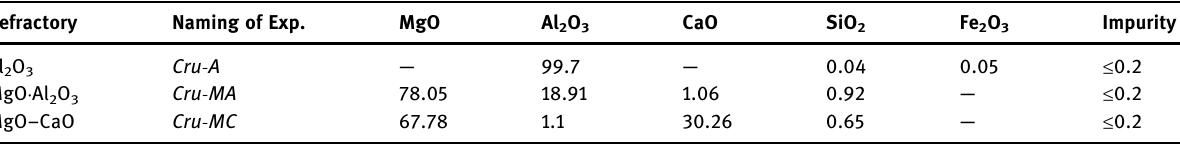
Table 3: Chemical composition of refractory ( wt% ) Refractory Naming of